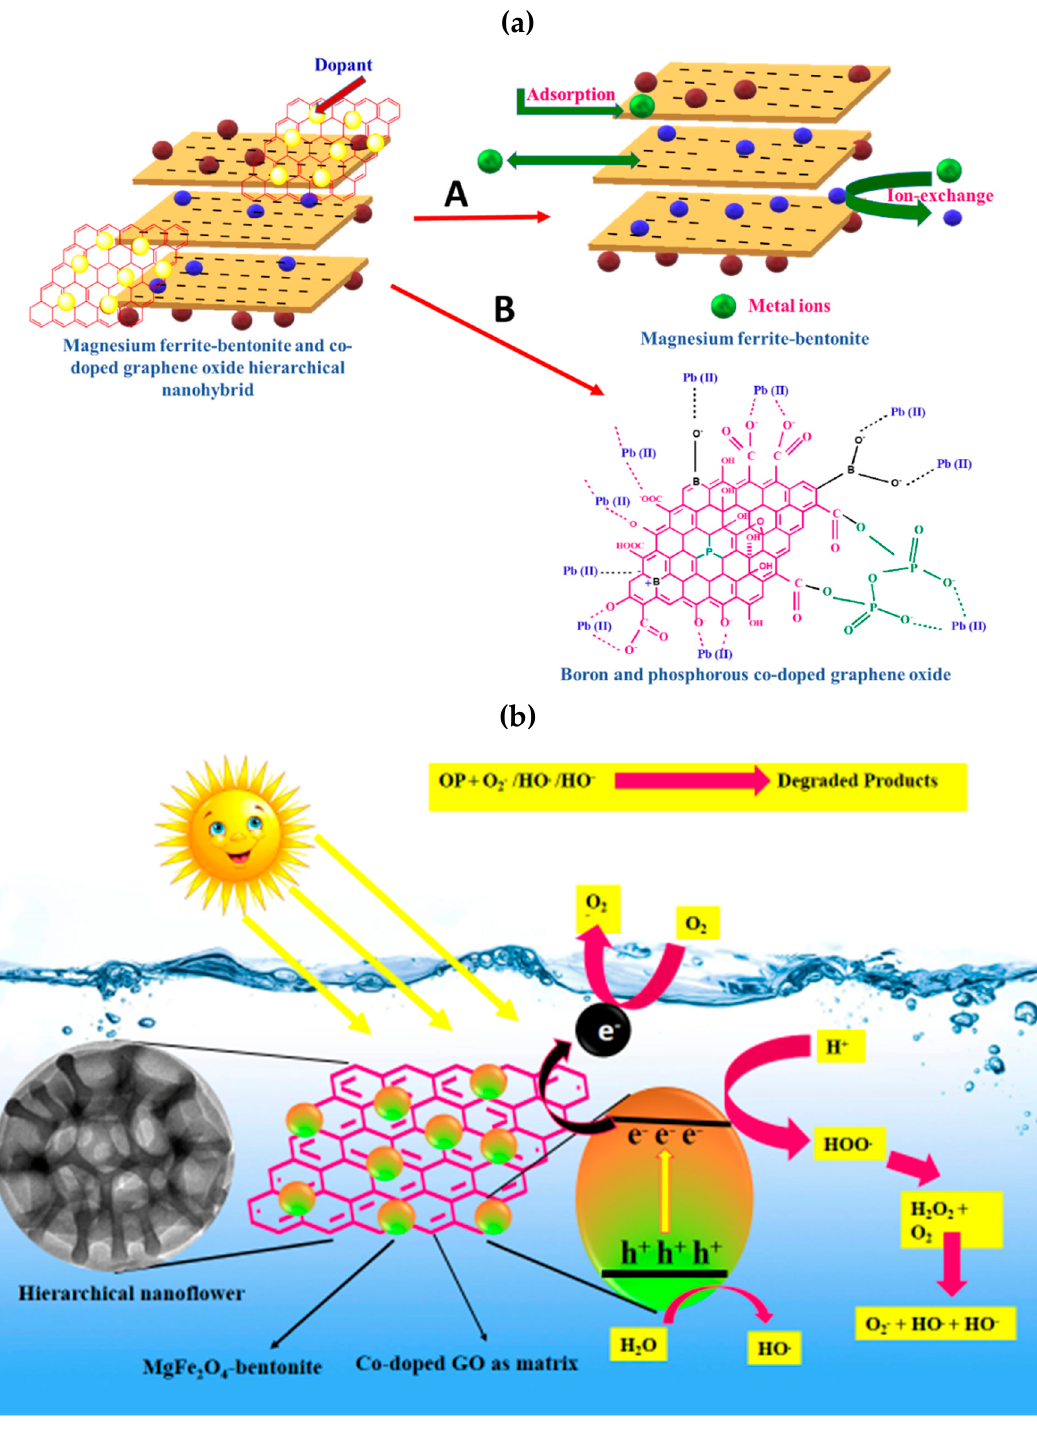
Figure 9. ( a ) Adsorption mechanism of Pb(II) ions by MGF-B (Path-A) and BPGO (Path-B) and ( b ) Photodegradation mechanism of malathion.